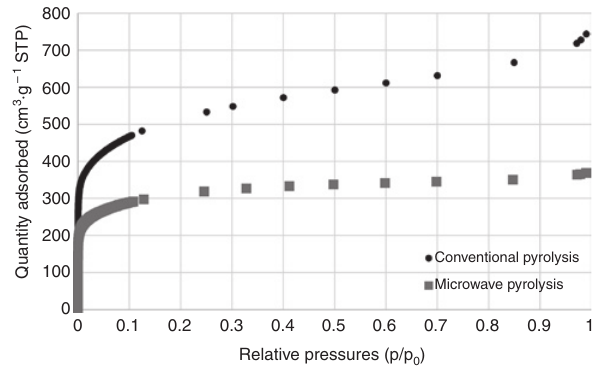
Figure 4: Adsorption isotherms of activated